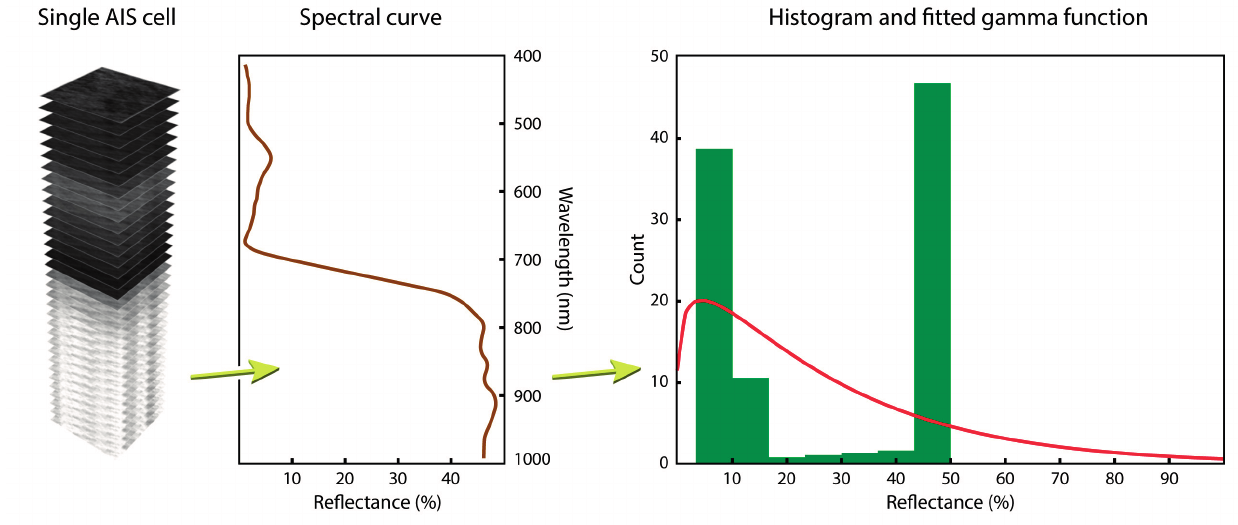
Figure 10. The principle of a pixel-wise PDF fitting: ( left ) hyperspectral pixel visualized as a raster cell; ( middle ) reflectance curve derived from the hyperspectral pixel; ( right ) histogram of the reflectance values and fitted theoretical PDF (in this case the gamma continuous probability distribution function). If done for each pixel in the scene, the resulting parameters (here the two parameters of the gamma function) can be visualized as an image (see Figure 11).